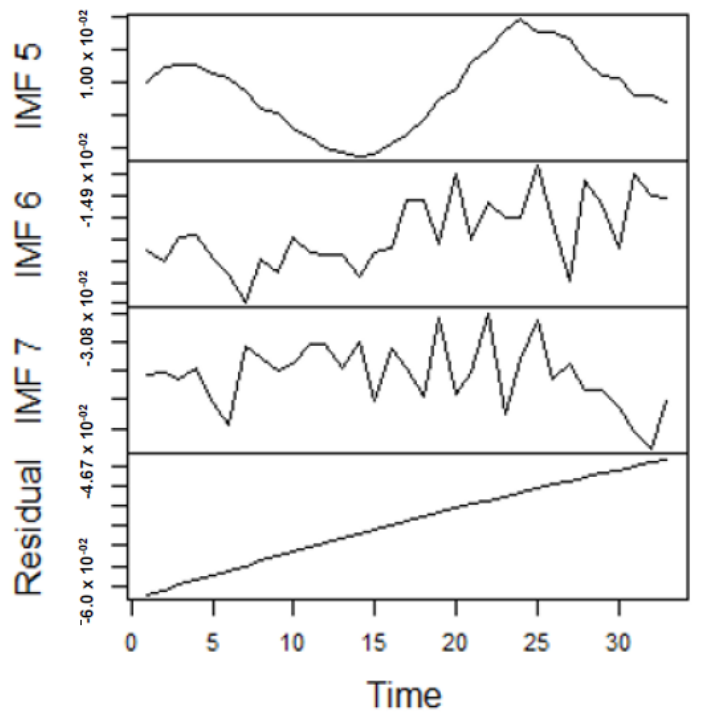
Figure 6. Part B: The remaining IMFs and residuals for US gas